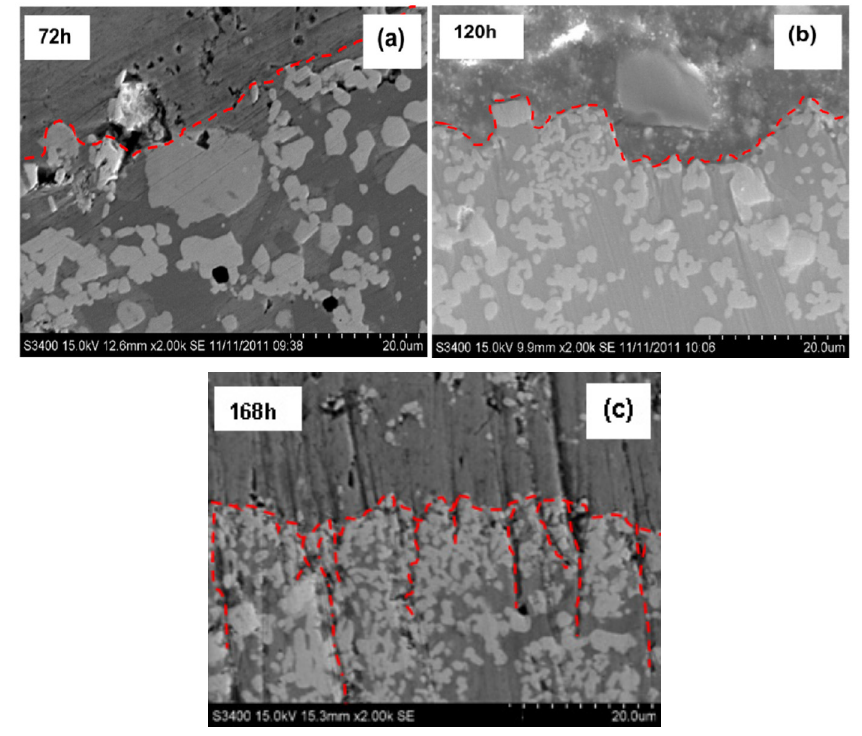
Figure 9. Microstructure of the sleeve coating after corrosion tests at: ( a ) 72 h; ( b ) 120 h; ( c ) 168